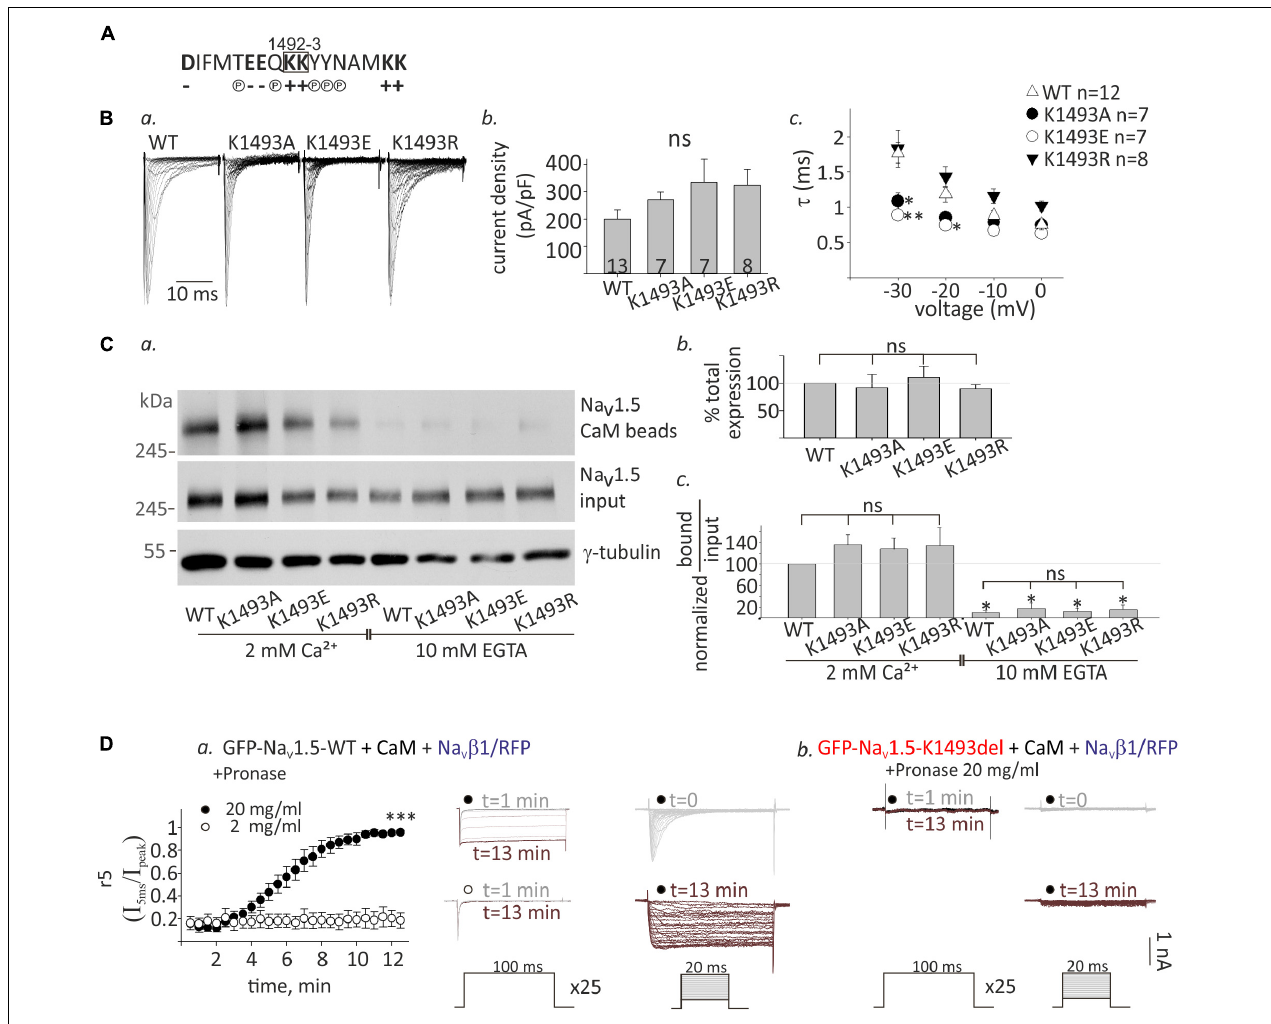
FIGURE 6 | Functional and biochemical role of K1493 residue. (A) The amino acid sequence of residues 1484–1500 in Na V 1.5. The double lysines 1492-3 are marked in a square. Amino acid’s charge (+ or–) or polarity (P) are indicated. (B) Na V 1.5 variants co-expressed with rNa V β 1. (a) Representative I Na traces recorded in (10 mM EGTA) in . (b) Maximal current densities. (c) Time constant ( τ ) obtained by fitting a single exponential to the decay phase of the currents in (10 mM EGTA) in at four voltages. Statistical significance was determined by one-way ANOVA followed by Holm–Sidak test (compared to Na V 1.5 WT ). (C) Cells were transfected with Na V 1.5 K1493A / E / R together with rNa V β 1. (a) Example of a pull-down experiment with CaM-agarose beads, in Ca 2 + and EGTA. (b) The total expression as quantified in EGTA, and normalized to Na V 1.5 WT ( N = 3). (c) Pull-down experiments with CaM-agarose beads. The CaM-bound fraction was normalized to input level and quantified as % of Na V 1.5 WT in 2 mM Ca 2 + ( N = 3). Statistical significance was determined by one-way ANOVA, followed by Holm–Sidak test, compared to WT in 2 mM Ca 2 + . ∗∗ p < 0.01; ∗ p < 0.05. (D) GFP-Na V 1.5 WT (a) or GFP-Na V 1.5 K1493del (b) coexpressed with rNa V β 1/RFP and CaM in HEK cells. 2 or 20 mg/ml pronase were added to (10 mM EGTA) in pipette solution. t indicates the time from the beginning of the recording. (a) Currents elicited from –120 mV to –20 mV for 100 ms, every 30 s. Between pulses, the cells were held at –120 mV. Inactivation was evaluated by r 5 , which is the fraction of current that remained after 5 ms at –20 mV (I 5 ms /I peak ), n = 5 in each group (left). Representative currents during repetitive steps to –20 mV (middle), and activation protocols in the same cell, at different time points (right). (b) Recording from cells expressing GFP-Na V 1.5 K1493del with 20 mg/ml pronase in the pipette solution. Currents during repetitive depolarization (left) and activation protocols (right) at different time points are presented. This is a representative cell out of 12 cells.